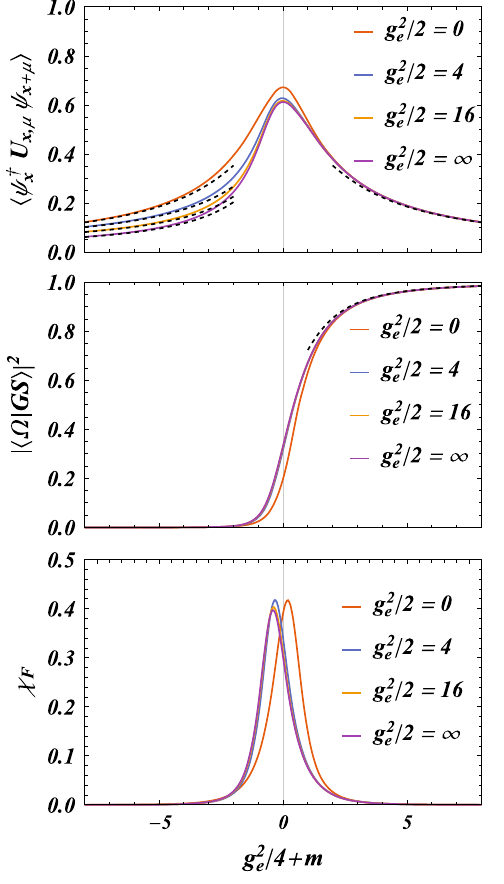
FIG. 18. Top panel: expectation value of the tunneling Ham- iltonian as a function of the distance from the classical transition for a 2 × 2 system. Center panel: module square of the overlap between the exact 2 × 2 ground state and the vacuum state when varying the coupling across the classical transition point. Dashed lines are the perturbative predictions. Bottom panel: fidelity susceptibility of the ground state as defined in the main